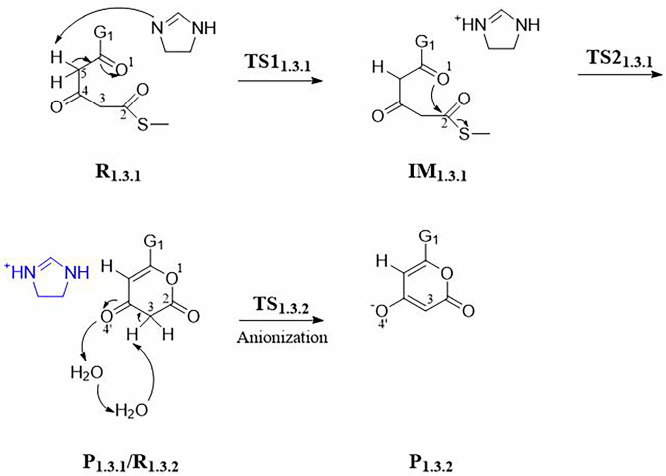
Scheme 5. The reaction process and predicted reaction mechanism of Step 1.3 of Stage 1. Blue molecules represent product molecules not involved in the next reaction. Group G 1 is shown in Scheme 1.